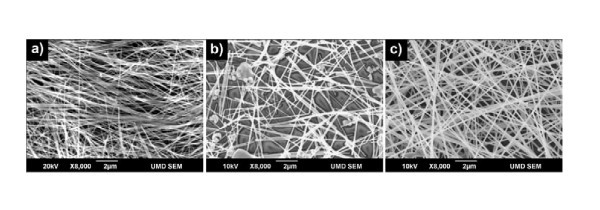
SEM images of as-purchased Ag NWs with different sizes. (a) 1#: dt = 66 nm, L = 7.4 μm; (b) 2#: dt = 102 nm, L = 15 μm; (c) 3#: dt = 122 nm, L = 34 μm.